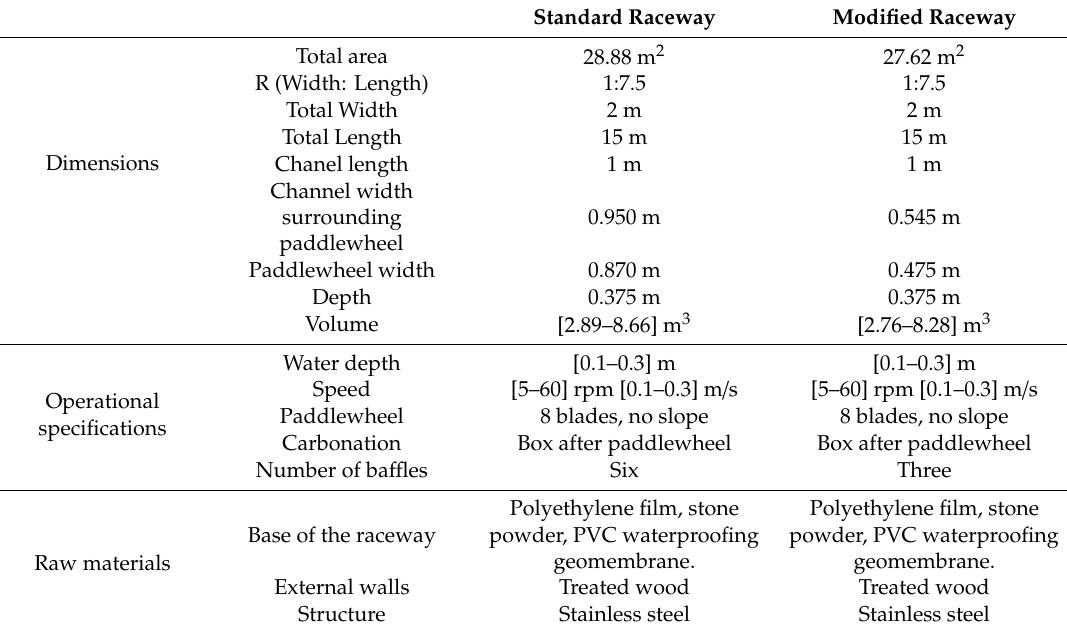
Table 1. General characteristics of the two built raceways: dimensions, operational specifications, and raw materials.